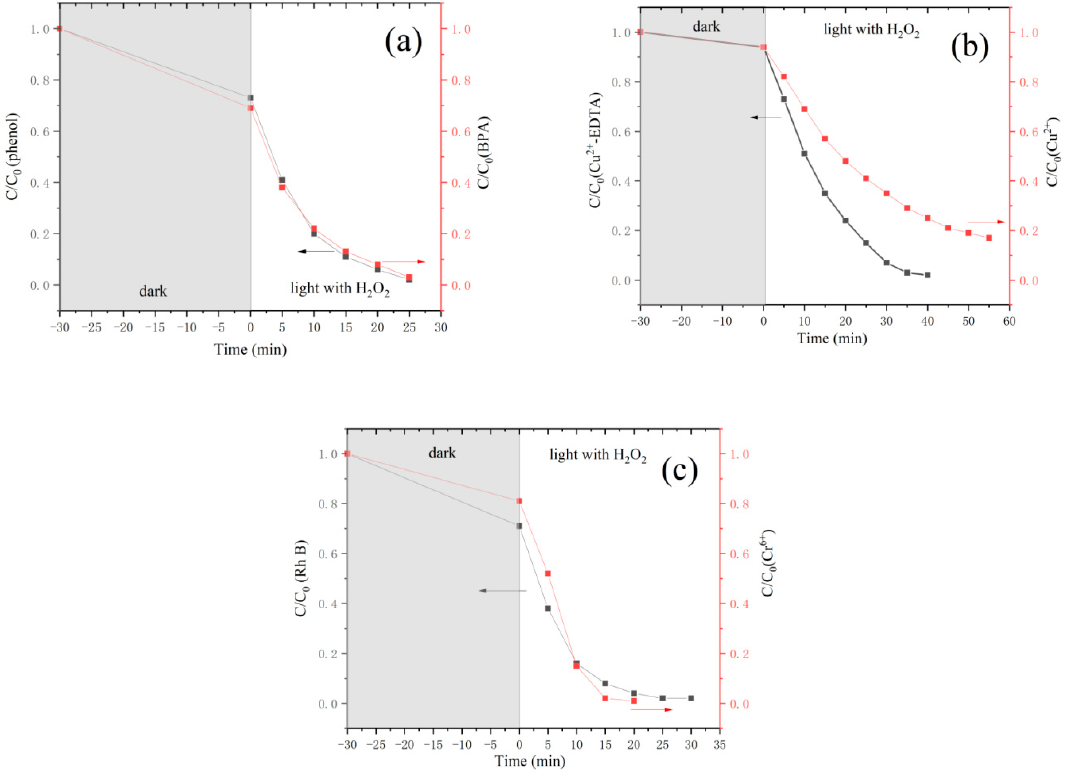
Figure 9. The synergistic effect of adsorption pre-concentration and photo-coordinated Fenton degradation of GO/Fe-GCN for phenol and BPA ( a ), Cu-EDTA ( b ), and complex pollutants containing Rh B and Cr 6+ ( c ).